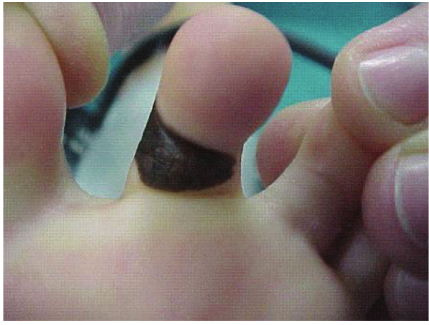
Figure 1: Site and features of the congenital compound nevus.